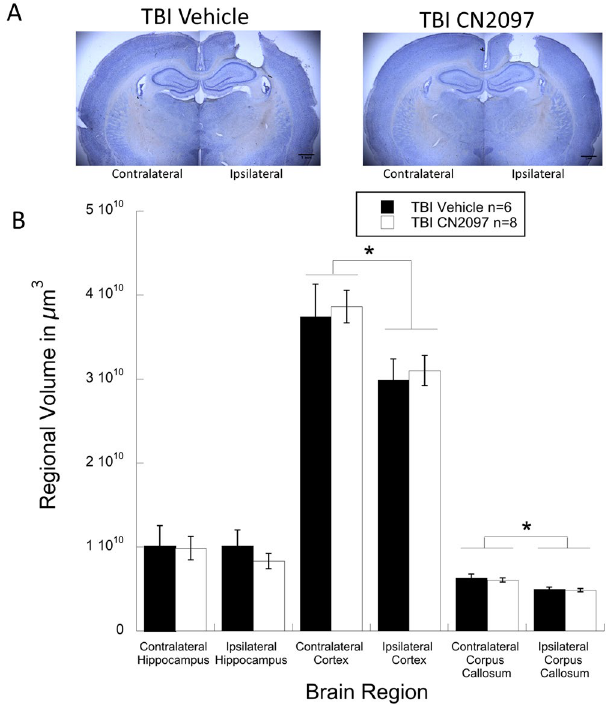
Figure 7. Brain regional volume analysis in CN2097- versus vehicle-treated rats. Photomicrographs ( A ) show coronal brain sections from ipsilateral and contralateral hemispheres from vehicle- and CN2097-treated rats, demonstrating comparable injury profiles. Bar graph ( B ) shows regional brain volume measurements for vehicle-treated (TBI Vehicle; n = 6) and CN2097-treated (TBI CN2097; n = 8) rats, indicating comparable ipsilateral and contralateral regional brain volumes of the cerebral cortex, hippocampus, and corpus callosum. * Indicates significant (p < 0.01) differences between ipsilateral and contralateral hemispheres for both treatment groups. Data represent mean ±